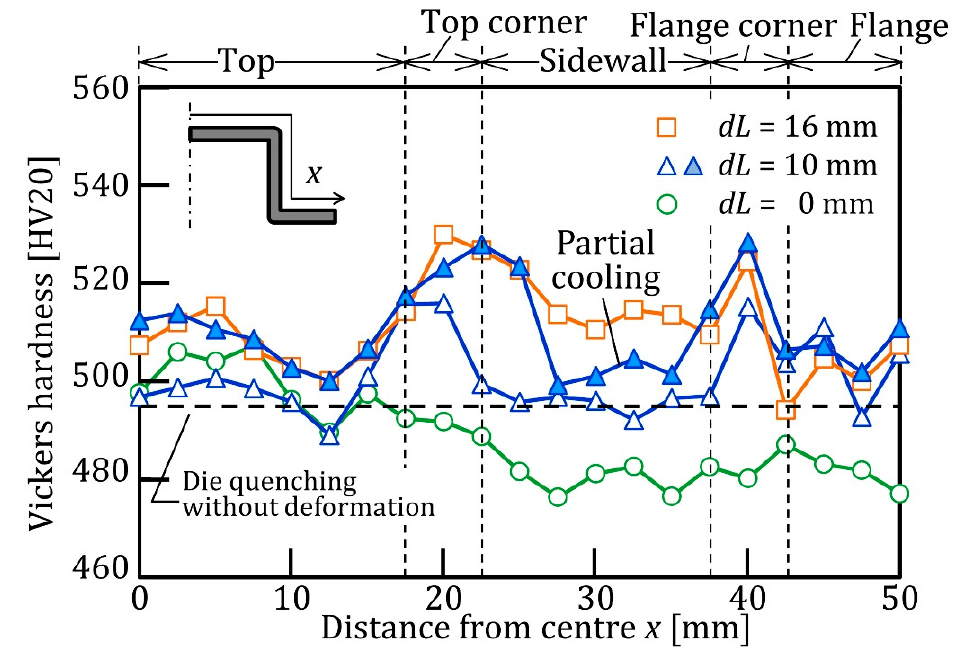
Figure 10. Distributions of Vickers hardness in hot hat-shaped bent parts.